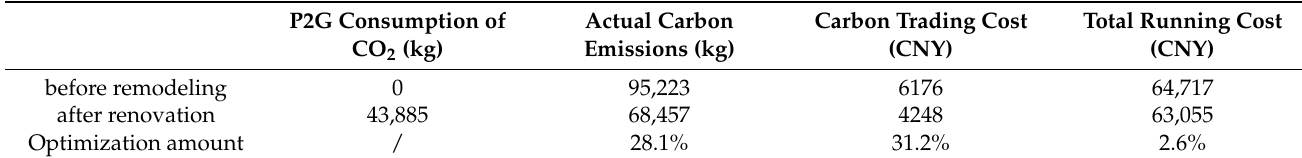
Table A2. Comparative analysis before and after the introduction of P2G in Micro-grid 2 for low- carbon